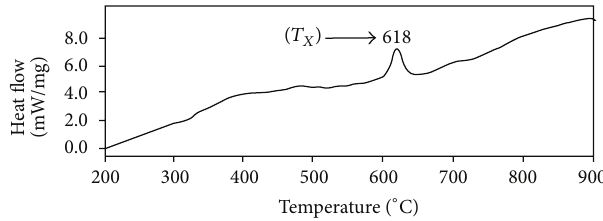
Figure 1: DSC scans of Nd 9.4 Pr 0.6 Fe 74.5 Co 6 B 6 Ga 0.5 Ti 1.5 C 1.5 .